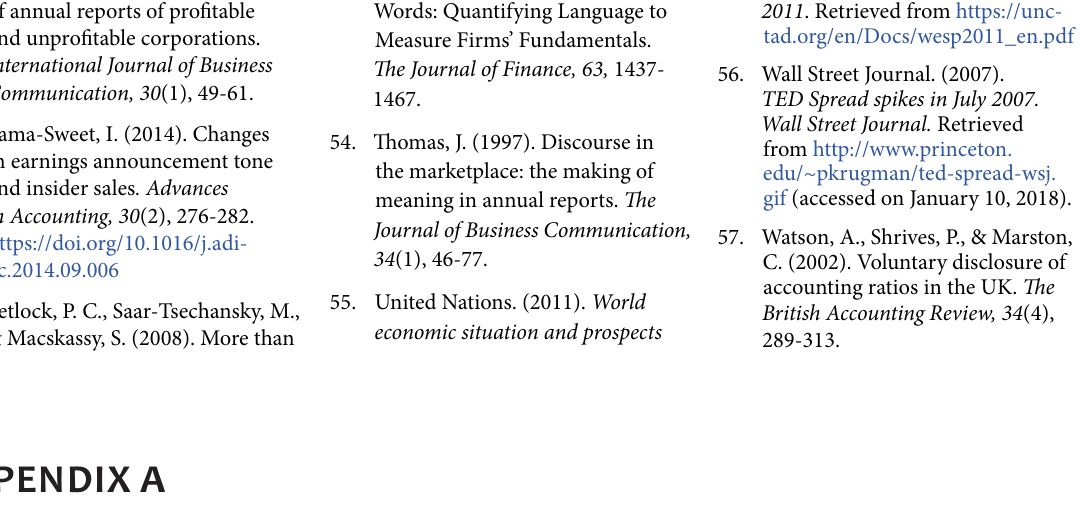
Table A1. List of banks used in the current